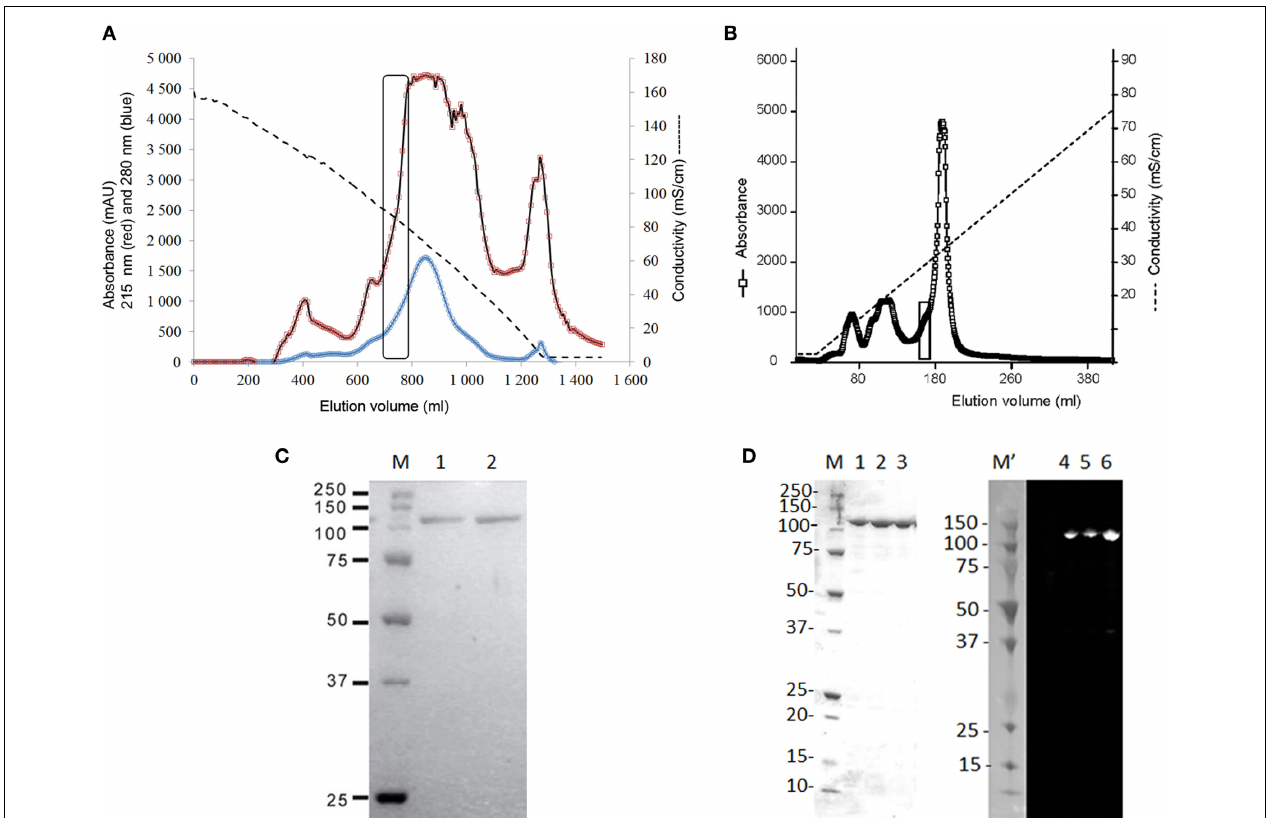
FIGURE 2 | Purification of the ι -carrageenan sulfatase. (A) Purification of the native ι -carrageenan sulfatase on a Phenyl Sepharose 6 fast flow high sub column (2.0 × 19.5cm). Elution of proteins was performed using a decreasing gradient from 30% saturation (NH 4 ) 2 SO 4 in buffer A to 0% (dashed lines). The absorbance of the fractions (6.5ml) was measured both at 280nm (blue curve) and at 215nm (red curve). Active fractions containing sulfatase activity are surrounded with a rectangle. They were pooled and dialyzed against buffer A prior being loaded on top of the anion exchange chromatography, as described in material and methods. (B) Purification of the native ι -carrageenan sulfatase on a DEAE-Sepharose fast flow column (1.6 × 13cm). Elution of proteins from the anion exchange chromatography was performed using an increasing gradient from 0 to 1M NaCl (dashed line). The absorbance of the elution fractions was measured at 215nm (open squares). Fractions containing pure Psc ι -CgsA are surrounded with a